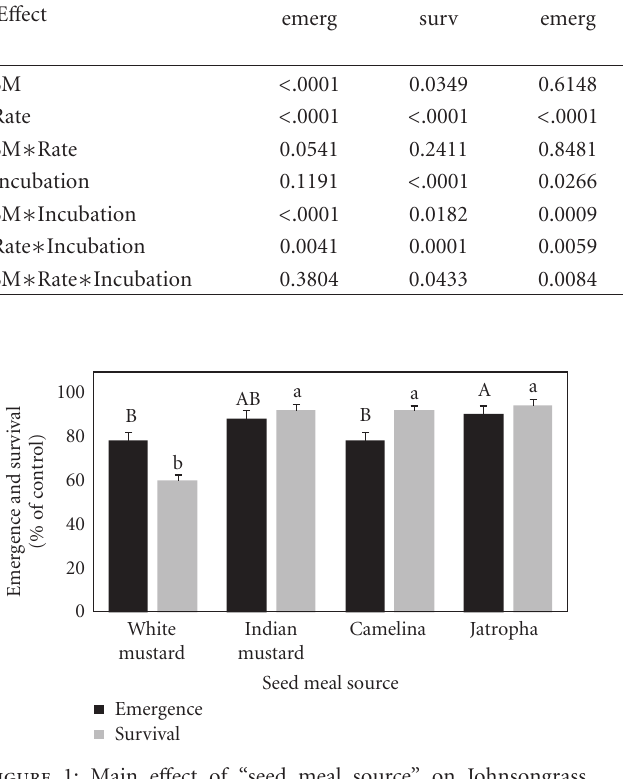
Johnsongrass Pigweed